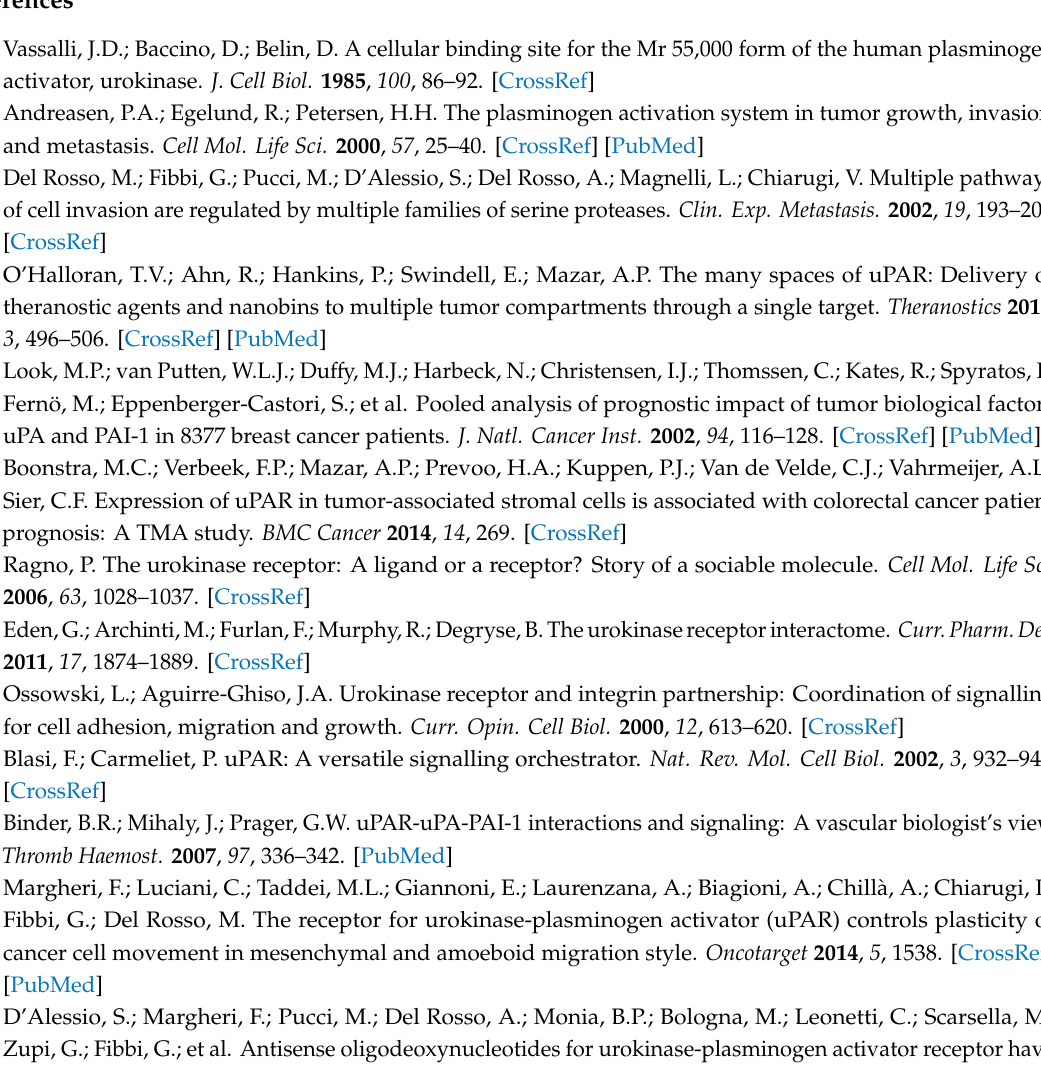
Figure S1: PLAUR expression screening after CRISPR transfection; Figure S2: uPAR KO